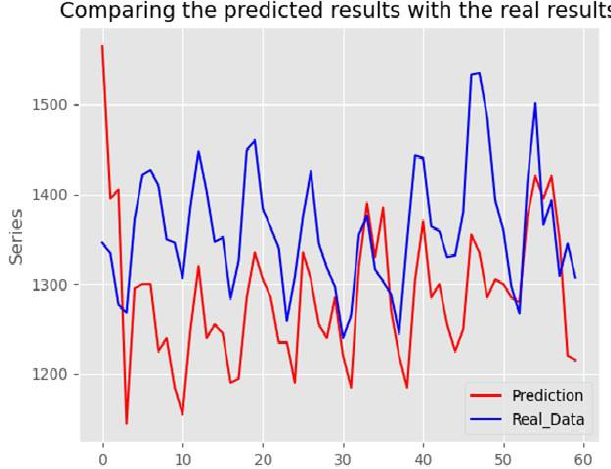
Figure 4 . Prediction of mean traffic for 60 days with L=10